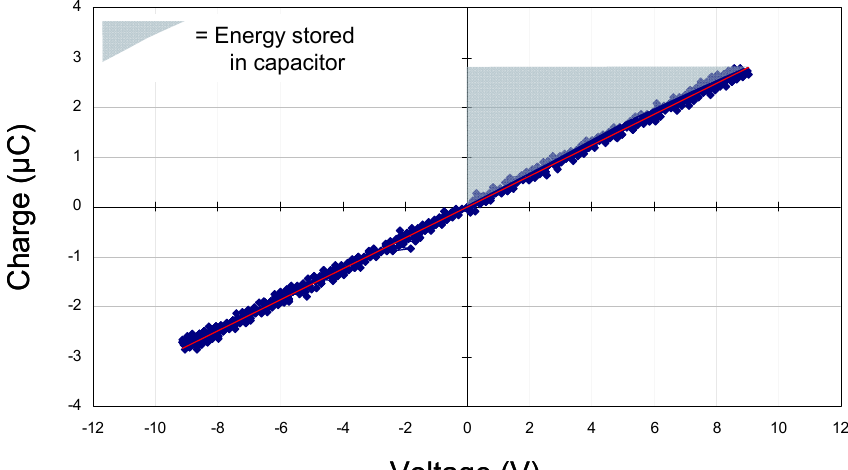
Figure 2. Charge vs . voltage for 330 nF standard commercial capacitor. The shaded triangle shows the amount of energy that can be stored in the device (  E ⋅ dq